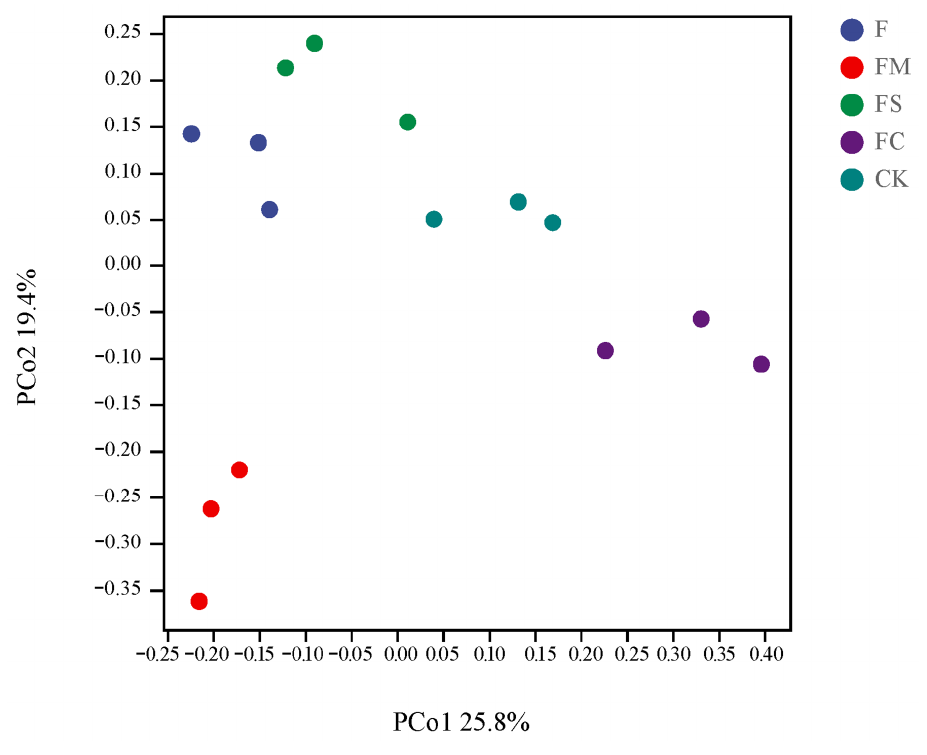
Figure 4. PCoA of eukaryotic microorganisms among different treatments. Note: F: chemical fertilizer; FM: chemical fertilizer + cattle manure; FS: chemical fertilizer + maize straw; FC: chemical fertilizer + pig manure; CK: control without fertilizers.